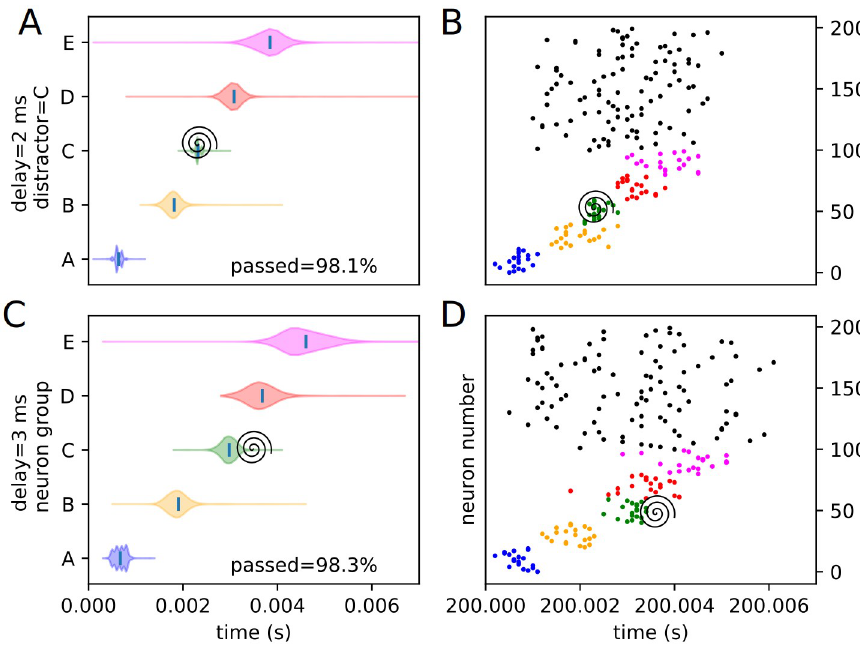
Fig 15. Experimental peak densities for late distractors at position C. Violin plots (densities estimated with a 50 point Gaussian kernel) of the peak times for the second two temporal variants of distraction at position C, with listed percentages of trials passing veto. A raster plot of an example distracted recall is also included. The spiral indicates the location of the distractor. (A) Violin plot for distractor C with 2 ms delay. (B) Example replay for distractor C with 2 ms delay. (C) Violin plot for distractor C with 3 ms delay. (D) Example replay for distractor C with 3 ms delay.